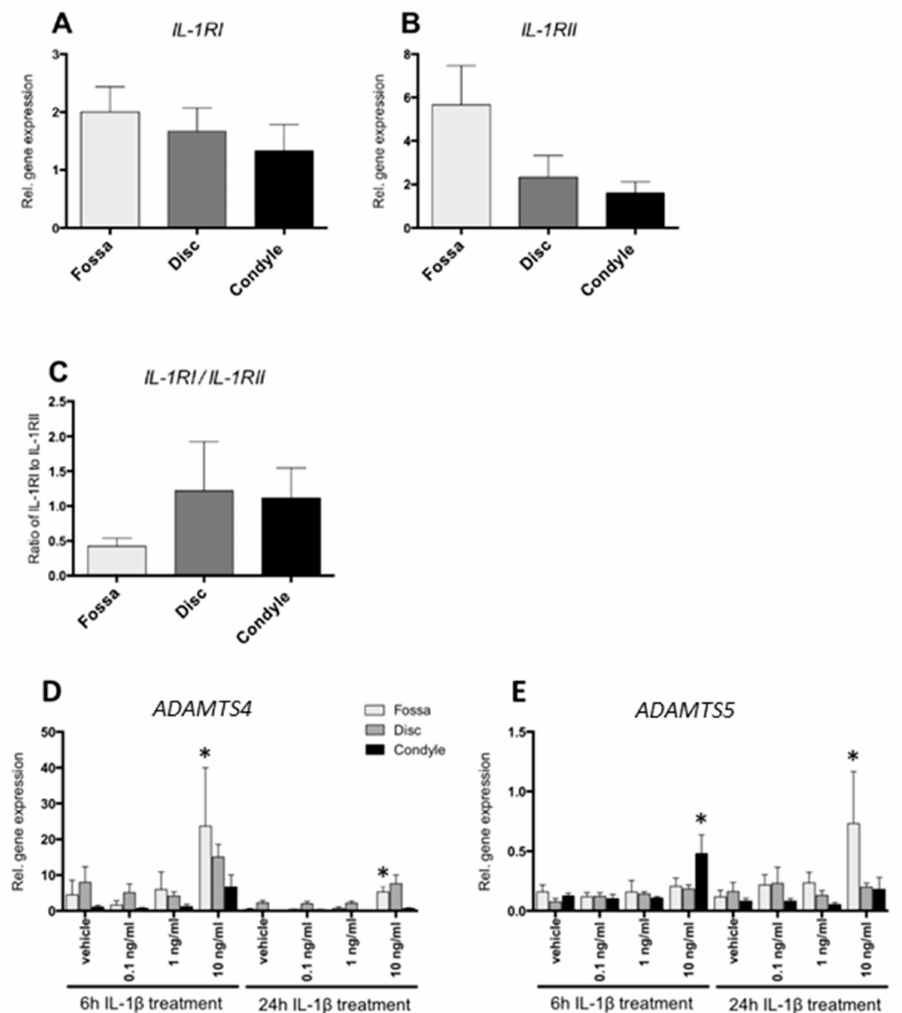
Figure 2. Relative gene expression of IL-1 receptor (IL-1R)I, IL-1RII, disintegrin and metalloproteinase with thrombospondin motifs (ADAMTS)4 and ADAMTS5 by porcine fossa, condyle and disc cells. ( A ) IL-1RI and ( B ) IL-1RII expression of the cells from fossa, disc, and condyle. All cells expressed IL-1RI and RII gene at similar levels. ( C ) The ratio between IL-1RI and IL-1RII . The ratio IL-1RI / IL-1RII was comparable for all cells. ( D ) ADAMTS4 expression in the cells from the fossa, disc, and condyle. IL-1 β incubation for 6 h enhanced ADAMTS4 expression in condyle cells. After 24 h of incubation with 10 ng / mL IL-1 β , both fossa and discs showed an increase in ADAMTS4 expression in comparison to the vehicle-treated cells. ( E ) ADAMTS5 expression in the cells from the fossa, disc, and condyle. Six hours of 10 ng / ml IL-1 β treatment enhanced ADAMTS5 gene expression in condyle cells. After 24 h of 10 ng / mL IL-1 β , the fossa cells showed an increased ADAMTS5 expression. * Significant e ff ect of treatment with IL-1 β relative to vehicle, p <